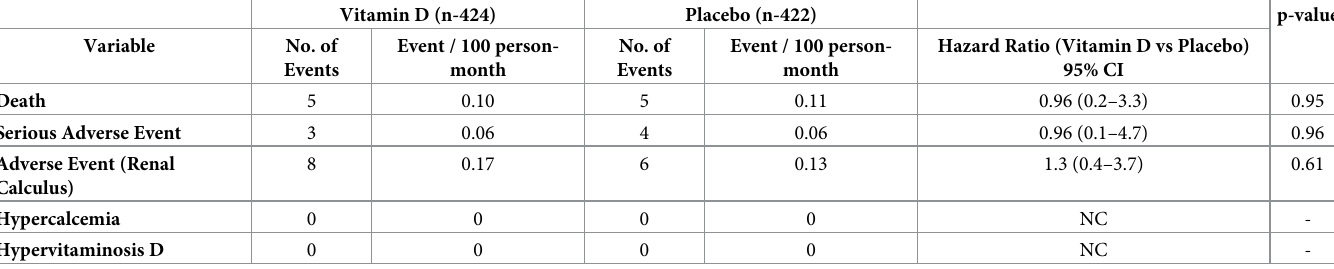
Table 4. Adverse events